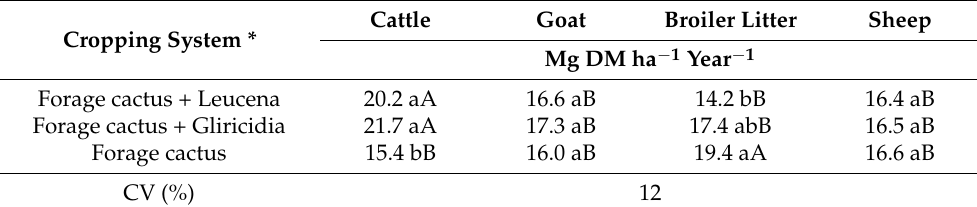
Table 3. Productivity of forage cactus clone IPA Sert â nia in different cropping systems and manure sources. Cropping System *